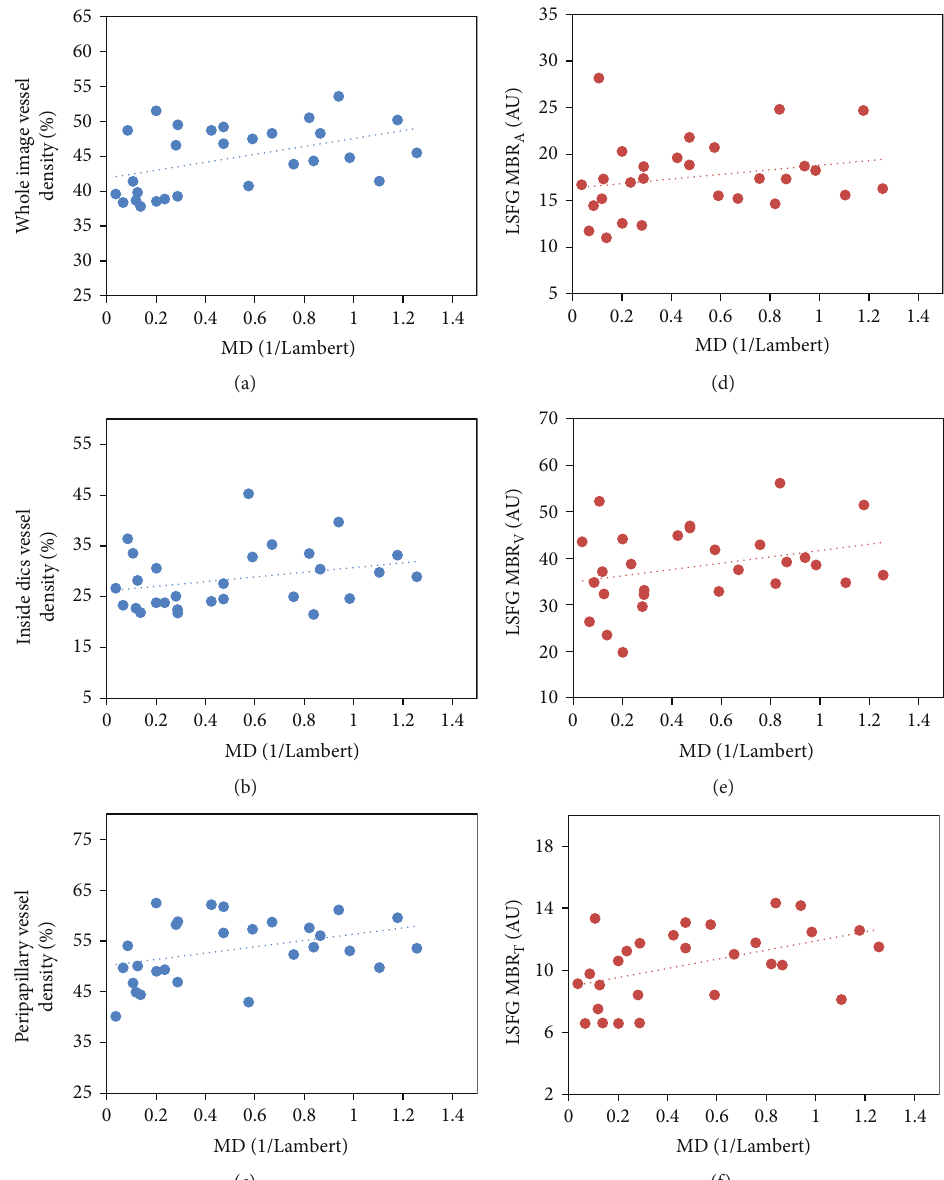
Figure 1: Scatter plots of MD by OCT-A whole image vessel density (a), inside disc vessel density (b), peripapillary vessel density (c), LSFG MBR (d), LSFG MBR (e), and LSFG MBR (f). MD =mean deviation; OCT-A =optical coherence tomography angiography; LSFG =laser A V T speckle fl owgraphy; MBR =mean blur rate inside the whole optic nerve head area; MBR A nerve head area; MBR =mean blur rate of the tissue area inside the optic nerve T